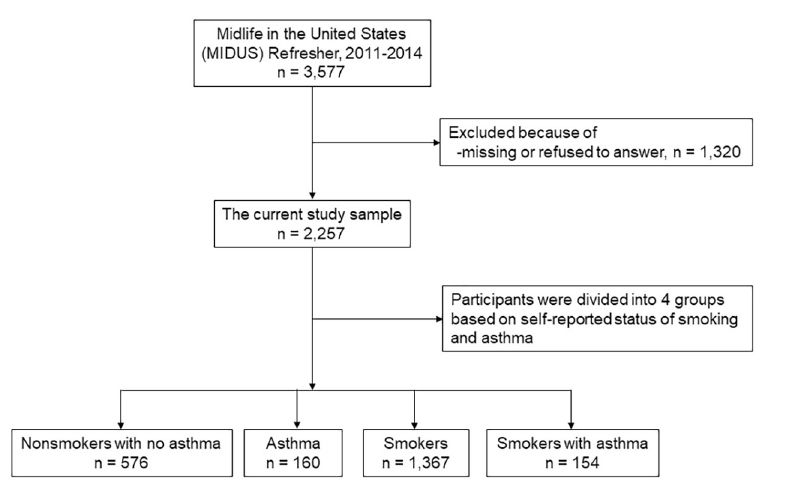
Fig 1. Flowchart of the study